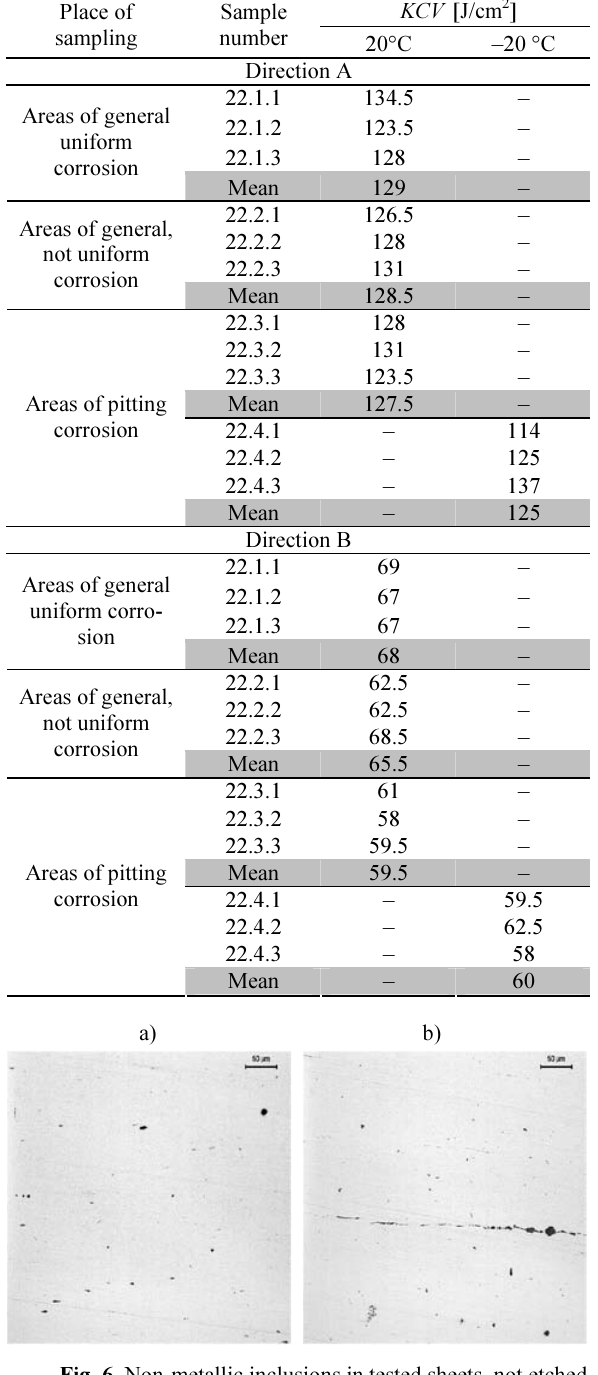
Fig. 6. Non-metallic inclusions in tested sheets, not etched polished sections, magnified 200 times: a) sheet from tank No. 3, b) sheet from tank No. 4, visible range of MnS cold shut Fracture morphology was examined using Joel scanning microscope, on samples of fractures